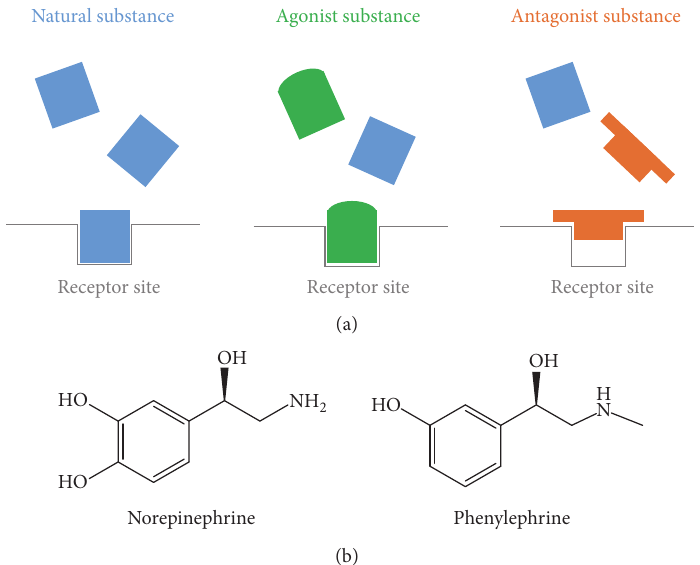
Figure 3: Agonist versus antagonist behaviour. The substances naturally produced by our body act on cellular receptors. The agonist is not the natural substance, but it acts similarly occupying the receptors and activating them, imitating or even enhancing therefore the effect produced by the natural substance. On the contrary, an antagonist mimics the natural substance to take its place in the receptor, blocking thus the cellular